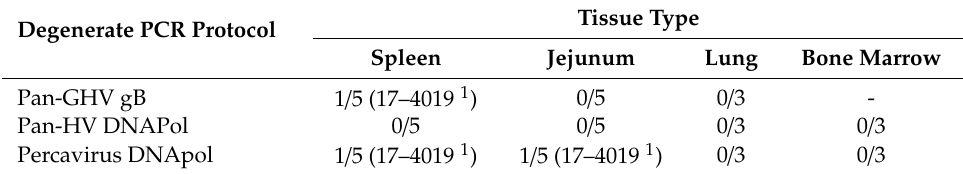
Table 2. Gammaherpesvirus (GHV) sequences detected in Canada lynx by degenerate pan-GHV PCR screening of di ff erent